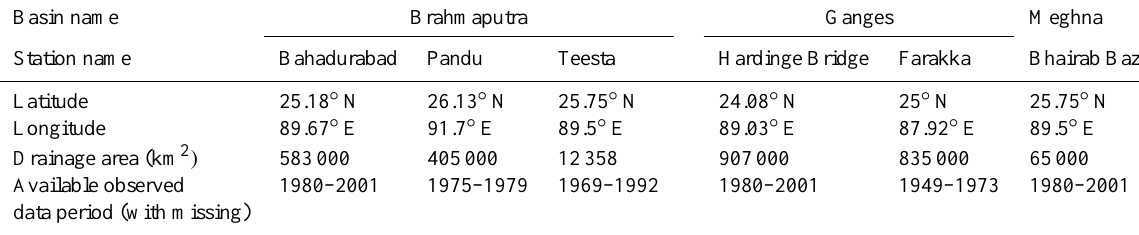
Table 3. Basic information of the streamflow validation stations in the GBM